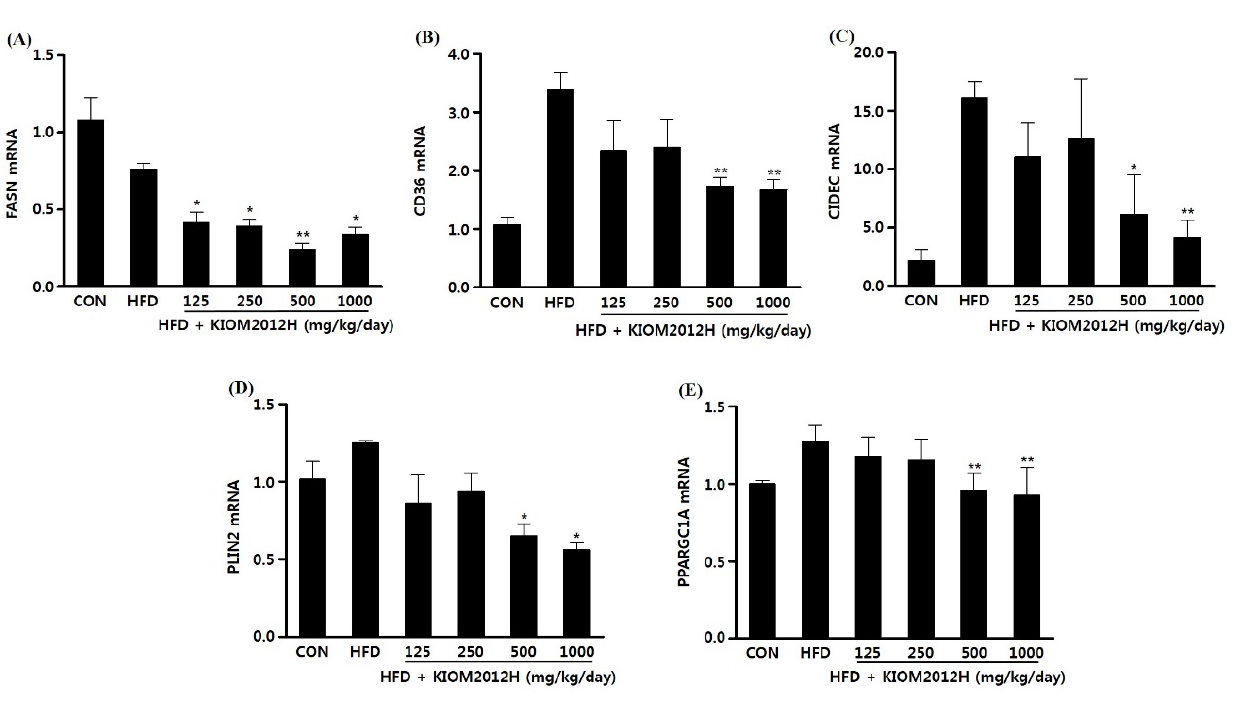
Figure 7. Relative expression levels of genes involved in FASN ( A ); CD36 ( B ); CIDEC ( C ); PLIN2 ( D ); and PPARGC1A ( E ) observed in mice liver nucleic acid ( n = 13). Data represent mean ± SE. Statistical differences from HFD are indicated by asterisks ( * p < 0.05, ** p <